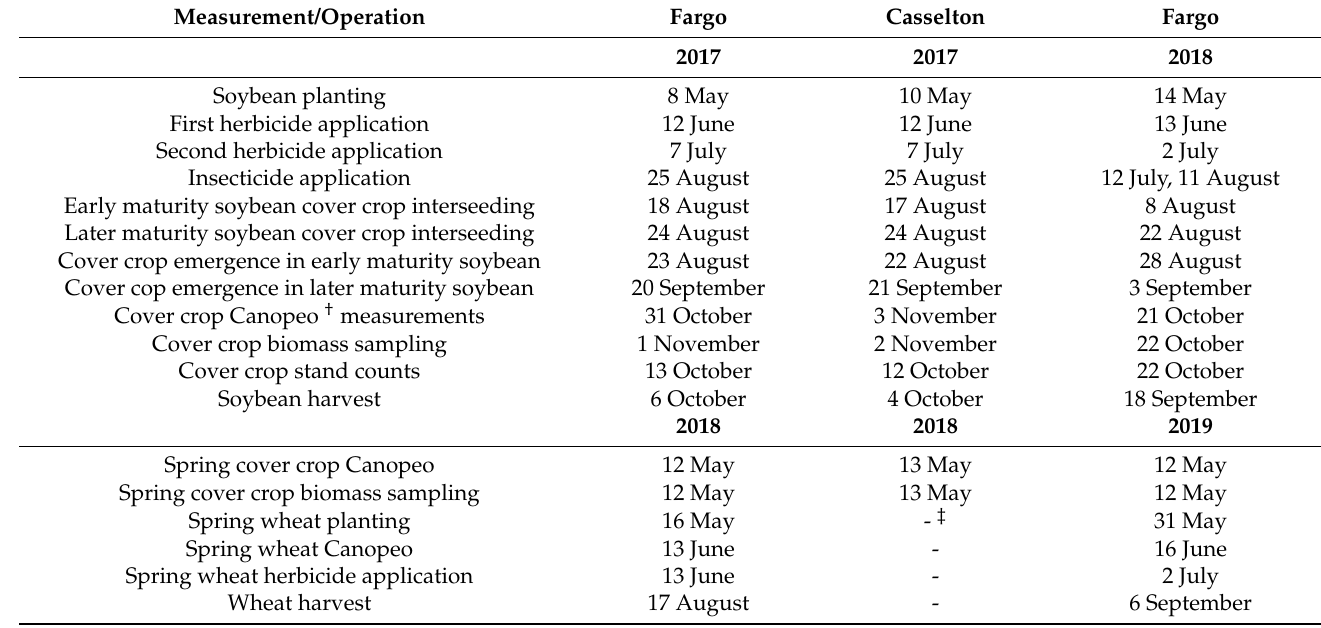
Table 3. Dates of important measurements and field operations at Fargo and Casselton, ND in 2017, 2018, and 2019.